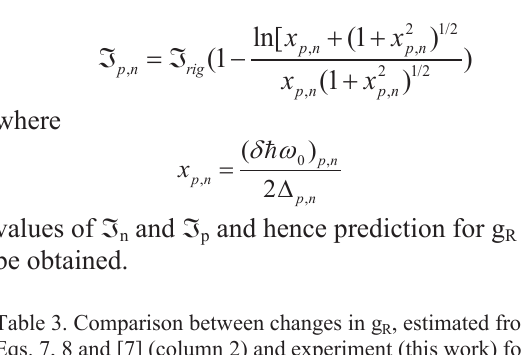
are Hf [0.280(7)] (cid:237) e)